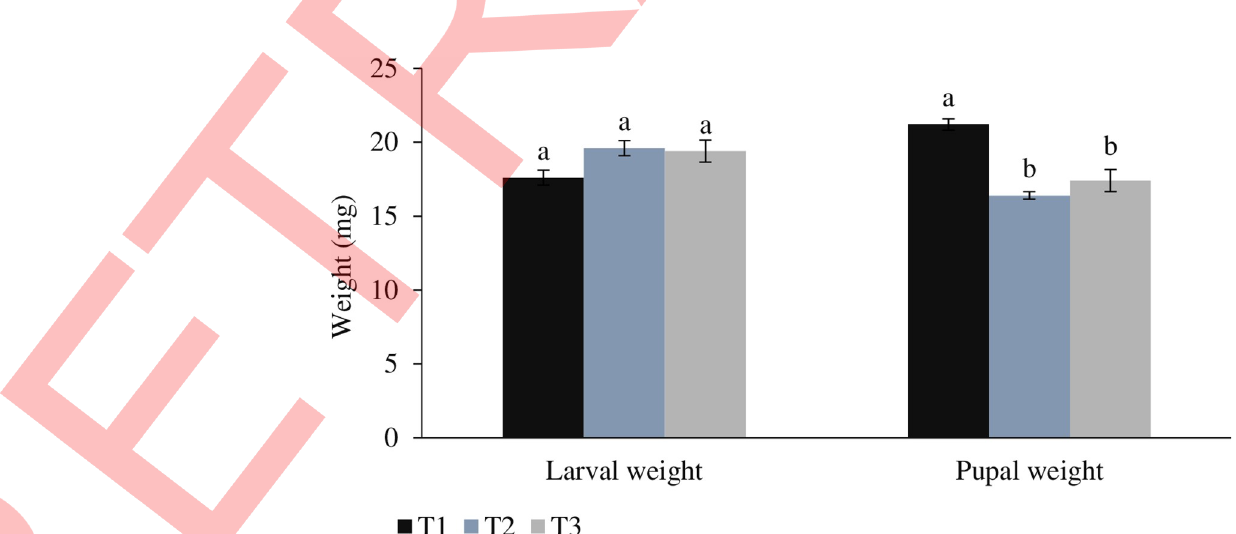
Fig 9. Larval and pupal weight (mean ± SE) of P . gossypiella on wheat germ, okra and chickpea diet. The means followed by bar gram by same letters are not significantly different at p > 0.05 by Tukey’s HSD test.